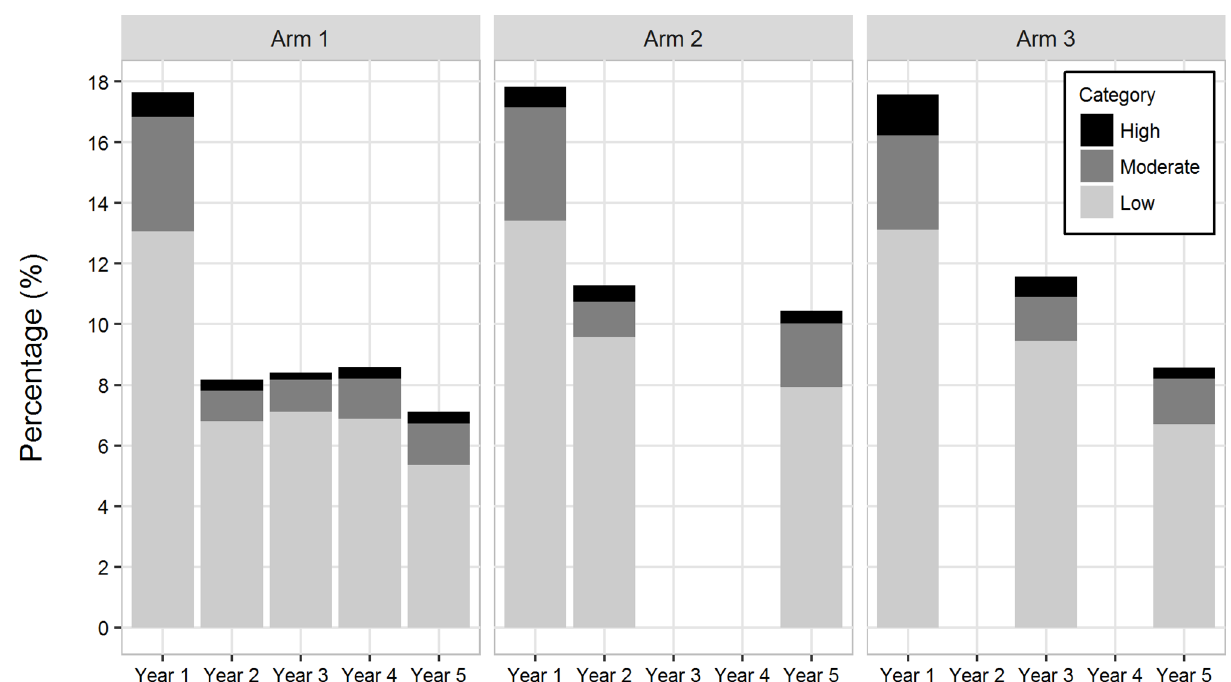
Fig 3. Overall mean prevalenceand mean prevalenceby infection intensity category by arm and by year. Total bar heightrepresents mean S . mansoni infectionprevalencein each year. Light grey represents the prevalenceof individuals with low intensity infections(1–99 epg); darker grey representsprevalenceof moderate intensity infections(100–399epg); and black representsprevalenceof individualswith highintensity infections( (cid:21) 400 epg).